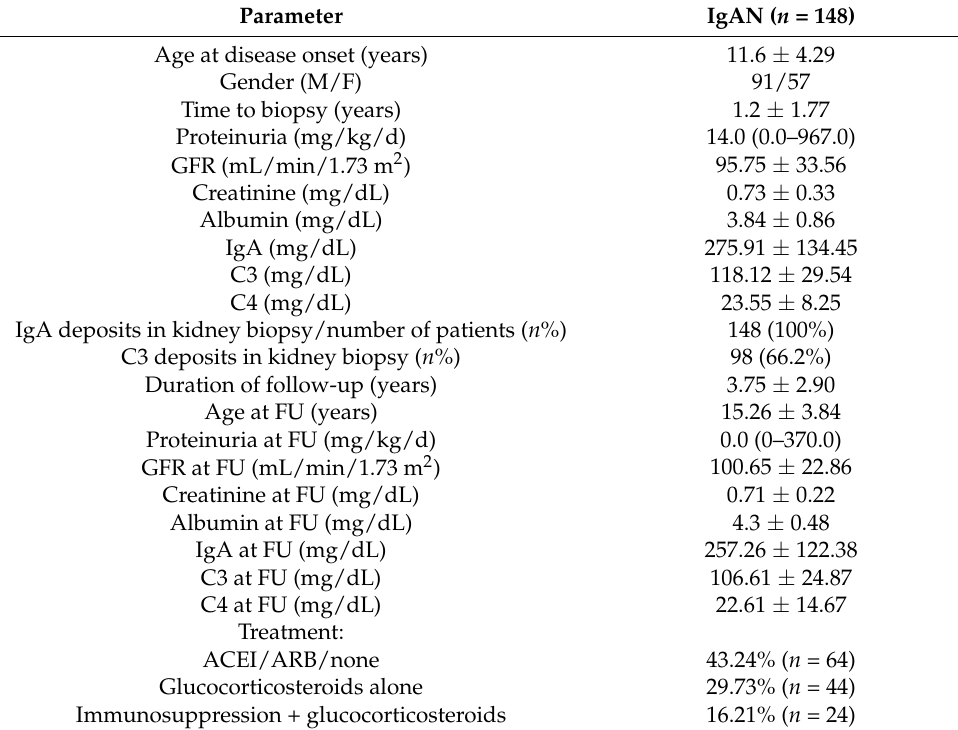
Table 1. Characteristics of the study